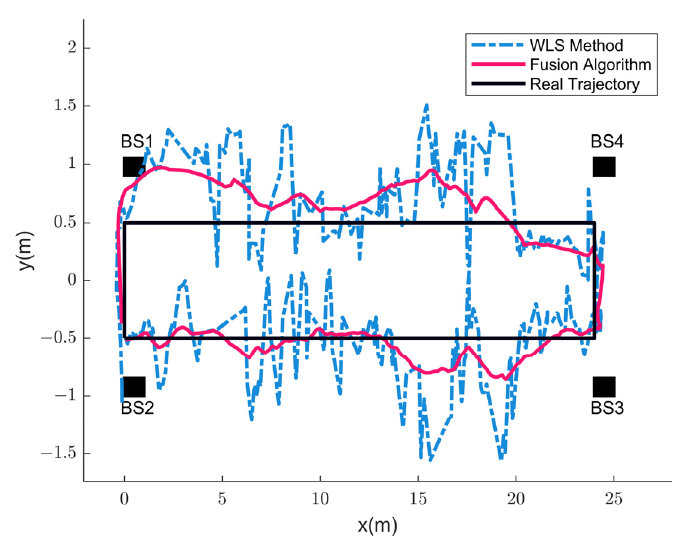
Figure 11. Dynamic trajectory diagram in Scene A.